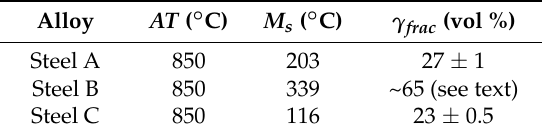
Figure 4. Typical examples of the optical micrographs of the dilatometry specimens for ( a ) Steel A, ( b ) Steel B and ( c ) Steel C. Table 4. Experimentally determined M s temperatures.